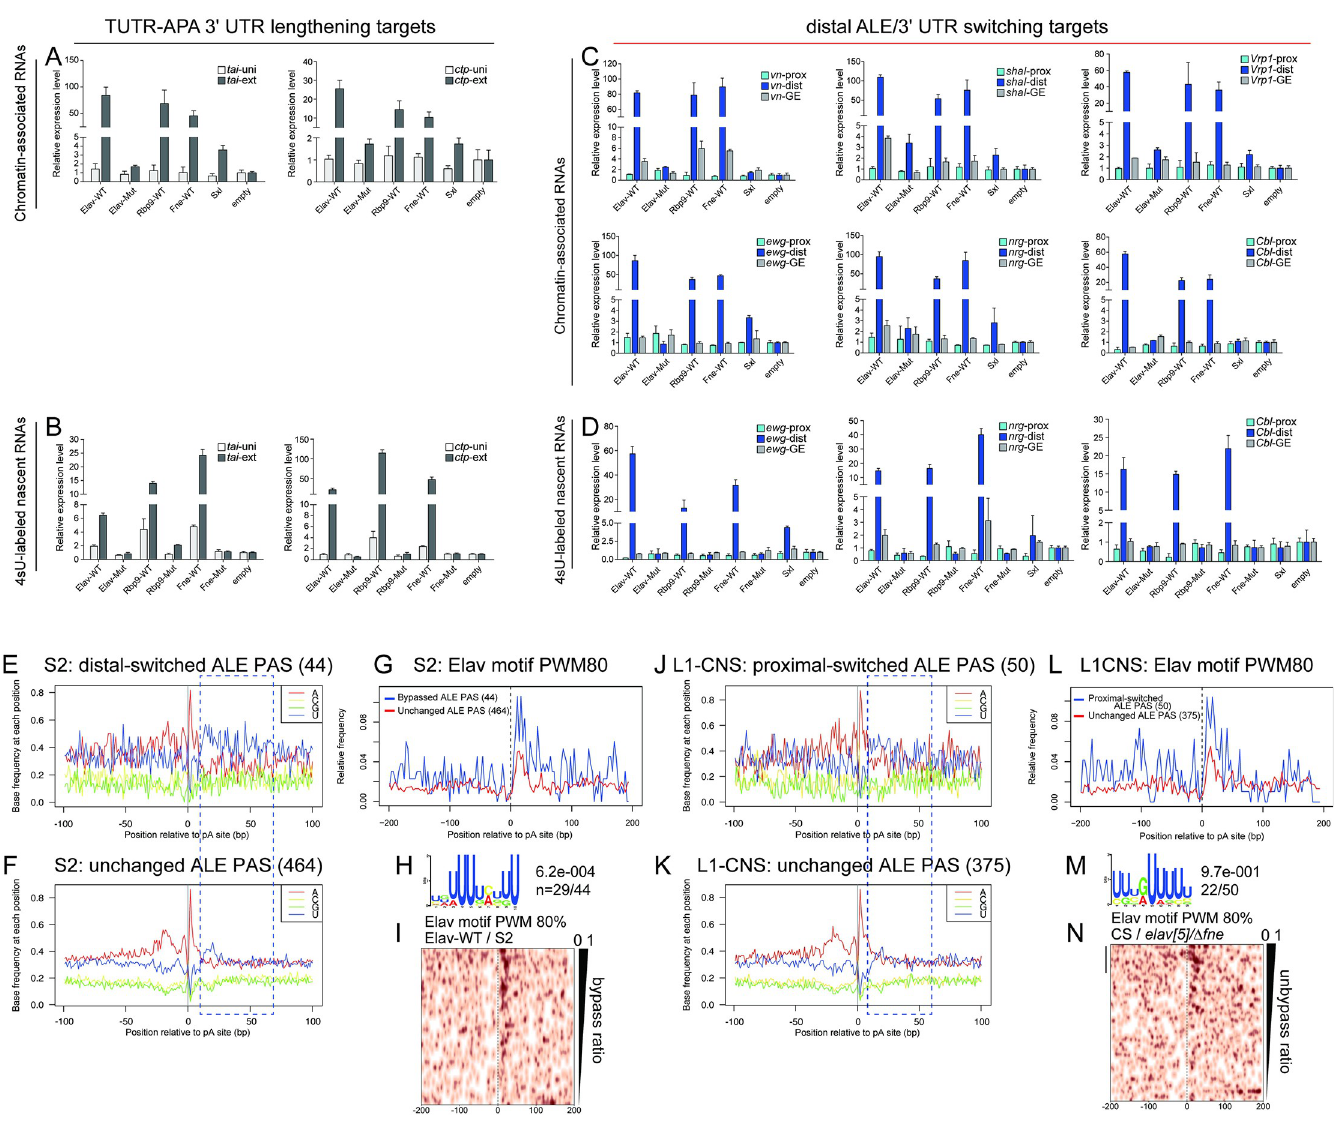
Fig 6. Mechanism of ALE-APA control by ELAV/Hu RBPs is shared with TUTR-APA targets. (A-B) Validation of new terminal 3’ UTR-APA (TUTR-APA) targets in the S2-GOF system. The 3’ UTR extensions of tai and ctp can be detected in chromatin-associated fractions (A) and in nascent transcripts isolated using 4sU labeling (B). (C) Distal ALE switching induced by GOF of ELAV/Hu RBPs also occurs in chromatin-associated fractions, but is not detected in RNA binding-defective Elav or with the homolog RBP Sxl. (D) Distal ALE switching induced by GOF of ELAV/Hu RBPs is detected in newly-synthesized transcripts. (E-I) Nucleotide and motif analysis of regions surrounding proximal ALE polyadenylation (pA) sites in S2 cells. (E-F) Nucleotide frequency of ALE cleavage sites that are bypassed by ELAV/Hu RBP-GOF (E) or that are unchanged (F) shows enrichment of downstream uridine amongst regulated loci. (G) Elav binding sites (80% match to position weight matrix, PWM80) are enriched downstream of regulated proximal ALE pA sites. (H) De novo search shows the Elav binding site is the most frequent and most significant motif downstream of regulated ALE pA sites. (I) Elav binding sites are correlated with the frequency of bypass as measured by distal isoform induction in the presence of ectopic Elav in S2 cells. (J-N) Nucleotide and motif analysis of regions surrounding proximal ALE pA sites in L1-CNS. (J-K) Nucleotide frequency of ALE cleavage sites that are switched from distal to proximal usage by elav/fne- LOF (J) or that are unchanged (K) shows enrichment of downstream uridine amongst regulated loci. (L) Elav binding sites are enriched downstream of regulated proximal ALE pA sites. (M) De novo search shows the Elav binding site is the most frequent and most significant motif downstream of endogenously regulated ALE pA sites in L1-CNS. (N) Elav binding sites correlate with distal-to-proximal ALE isoform switching in elav/fne mutant